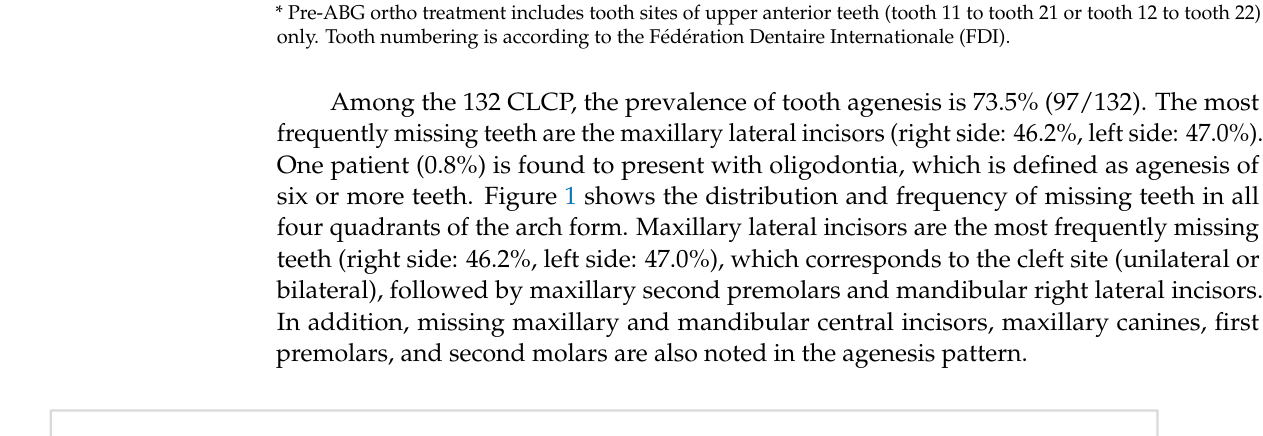
Table 5. Patient distribution in whether pre-ABG orthodontic treatment was received and the mean age of orthodontic treatment and ABG. ABG Pre- ABG Ortho *